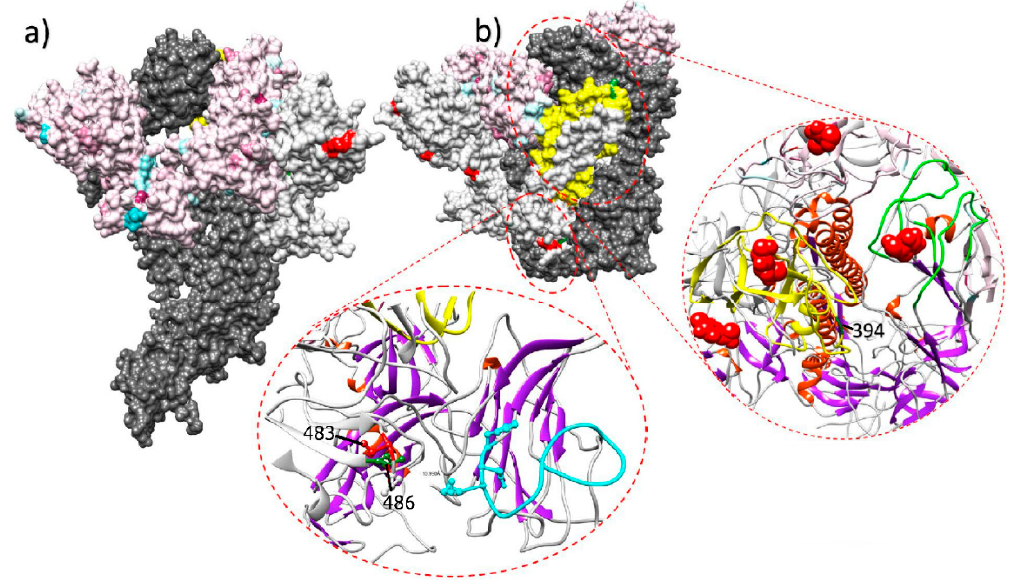
Figure 1. Lateral ( a ) and upper ( b ) view of the quaternary structure of the IBV spike protein. The full spike protein is reported for one monomer only (dark gray), while other monomers have been edited to highlight di ff erent selective pressure features. In the color-coded monomer, sites under a stronger selective pressure before the homologous vaccination introduction are reported in light blue, while the ones under a stronger selective pressure after the vaccination change are coded in purple. In the white-colored monomer, sites under episodic diversifying or directional selection in the post-vaccination change period are reported in red and green, respectively. The region demonstrating the stronger diversification tendency after the homologous vaccination introduction is highlighted in yellow. The ribbon visualization of relevant protein domains is reported as inserts. Lower insert reports S1 N-terminal receptor binding motif and the partial ceiling over it (coded in light blue). Sites of the nearby monomer under episodic diversifying and directional selection in the post-vaccination period are reported in red and green, respectively. The right insert displays the S1 C-terminal domain region. Two monomers are represented: one depicting the region with the highest diversification tendency after the homologous vaccination introduction (in yellow) and the other highlighting the corresponding extended putative receptor binding motif loops (in green). Figure from